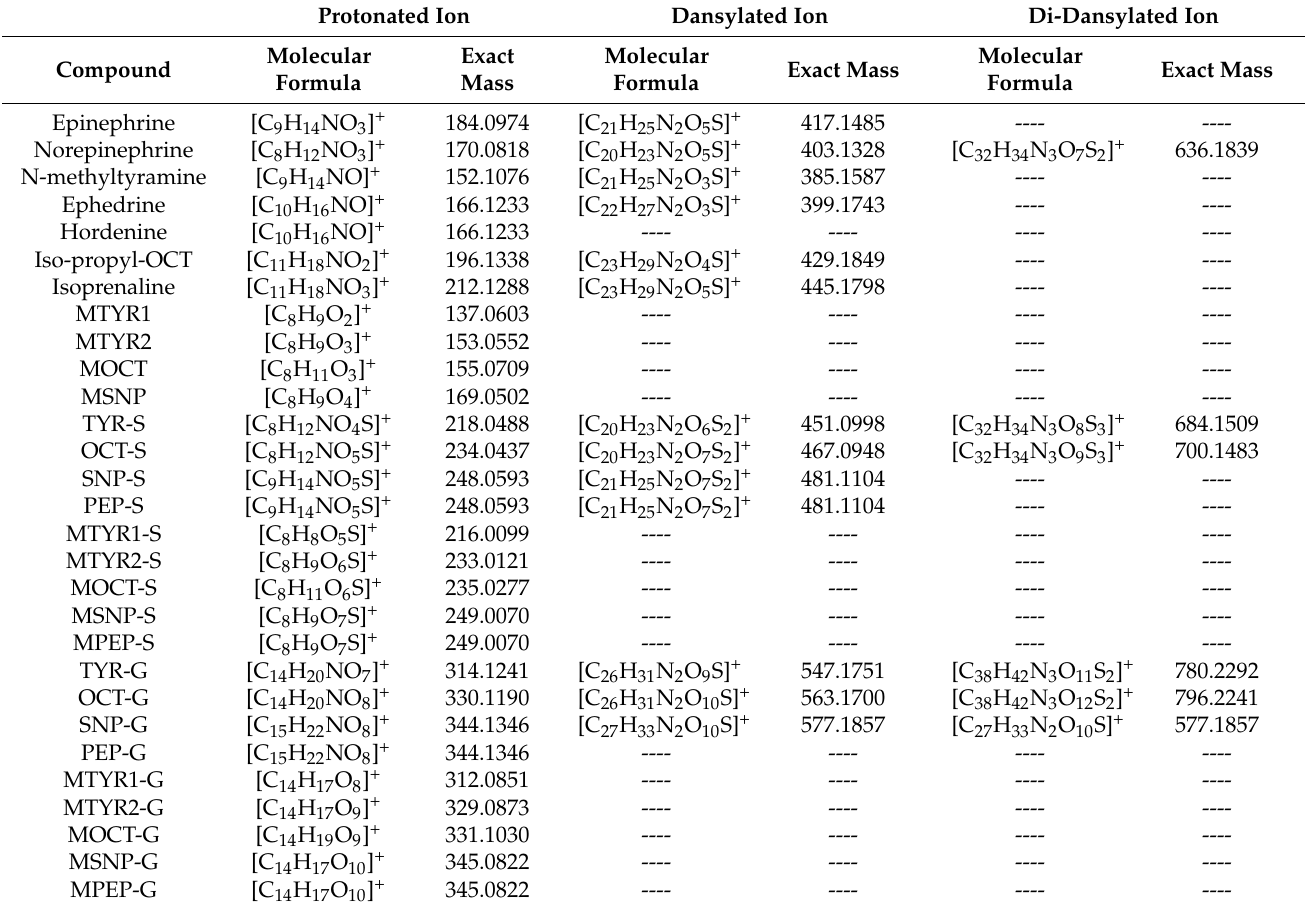
Table 5. BA-related compounds and metabolites monitored using the non-targeted approach. Protonated Ion Dansylated Ion Di-Dansylated